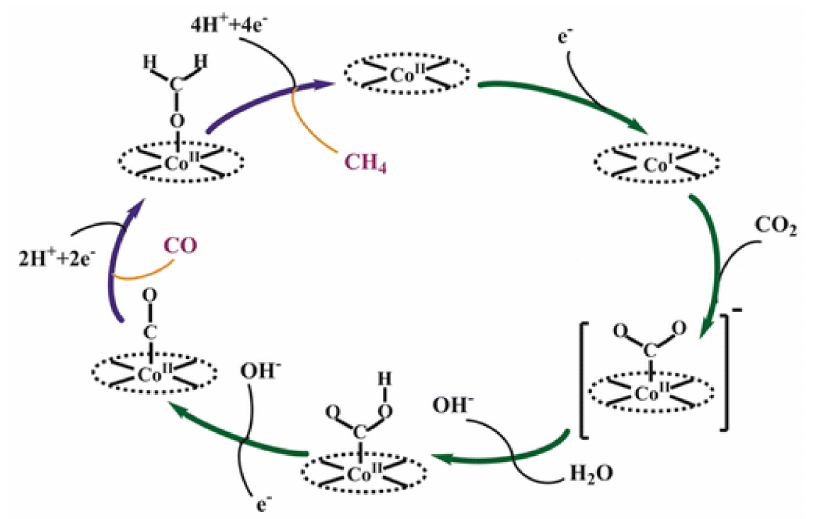
Figure 9. Mechanism of the electrochemical CO 2 reduction catalyzed via the Co-Porphyrins. Repro- duced from [154], with permission from Chemical Society,